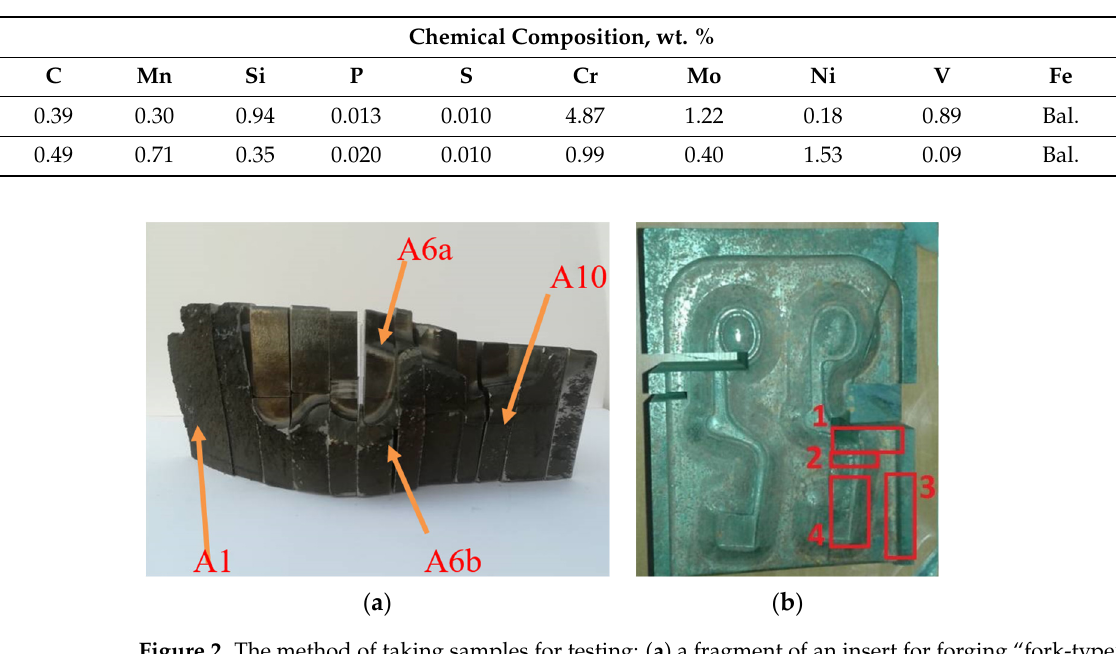
Figure 2. The method of taking samples for testing: ( a ) a fragment of an insert for forging “fork-type” forgings; ( b ) the die for forging wound spreader components.